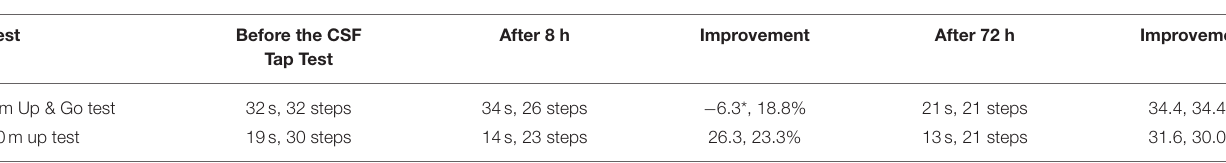
TABLE 2 | The CSF tap test